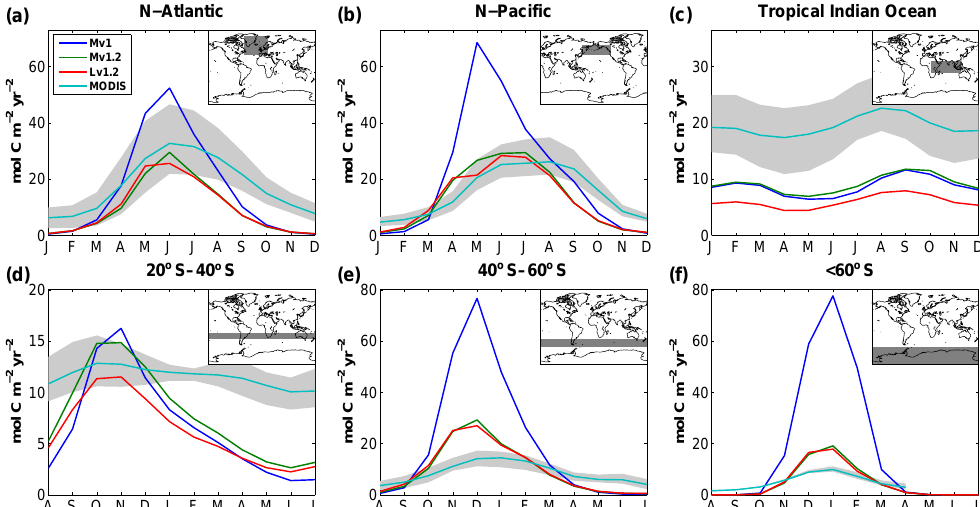
Figure 8. Mean seasonal cycle of vertically integrated primary production over the years 2003–2012 for the (a) North Atlantic, (b) North Pacific, (c) tropical Indian Ocean (Indian Ocean between 20 ◦ S and 20 ◦ N), (d) southern subtropics (40 to 20 ◦ S), (e) latitudes between 60 and 40 ◦ S, and the (f) Southern Ocean south of 60 ◦ S. Shown are the results for model configurations Mv1 (dark blue), Mv1.2 (green), and Lv1.2 (red) and the mean and range of the satellite-derived seasonal cycle (light blue and grey shaded areas).